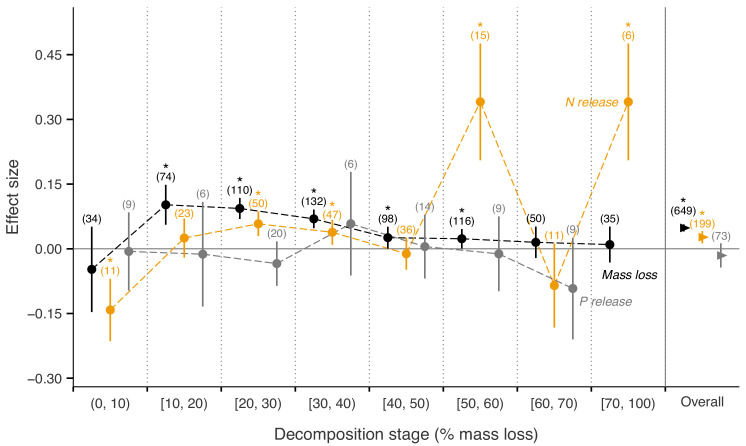
Litter mixture effects on mass loss (solid black triangles or circles), N release (solid yellow triangles or circles), and P release (solid grey triangles or circles) at different mass-loss intervals during the decomposition process (% mass loss indicated the expected values calculated from the mass loss of the individual component species).Effect sizes were calculated as the log response ratio between observed and expected values for each response variable and 95% bootstrap confidence intervals (CI) are shown. Data at each harvest time of the decomposition experiment were used to calculate the effect size of each variable. We created intervals of 10% increments in mass loss up to 70% of mass loss, but did not distinguish further the final interval from 70% to 100%, because of only few observations within this range of mass loss. The slightly different positions of symbols within each interval is to better differentiate among curves of mass loss, N release, and P release and has no other meaning. The solid horizontal black line indicates no effects (mean effect size = 0, observed values = expected values). Mean effect size >0 indicates synergistic effects (observed values > expected values), while mean effect size <0 indicates antagonistic effects (observed values < expected values). The non-additive effects (synergistic or antagonistic) are significant at α = 0.05 if the CI of the effect size does not overlap with the zero line, while the effects are additive when there is overlap. Values in parentheses above the symbols denote the number of observations and asterisks indicate a significant mixture effect (i.e. a significant deviation from 0).